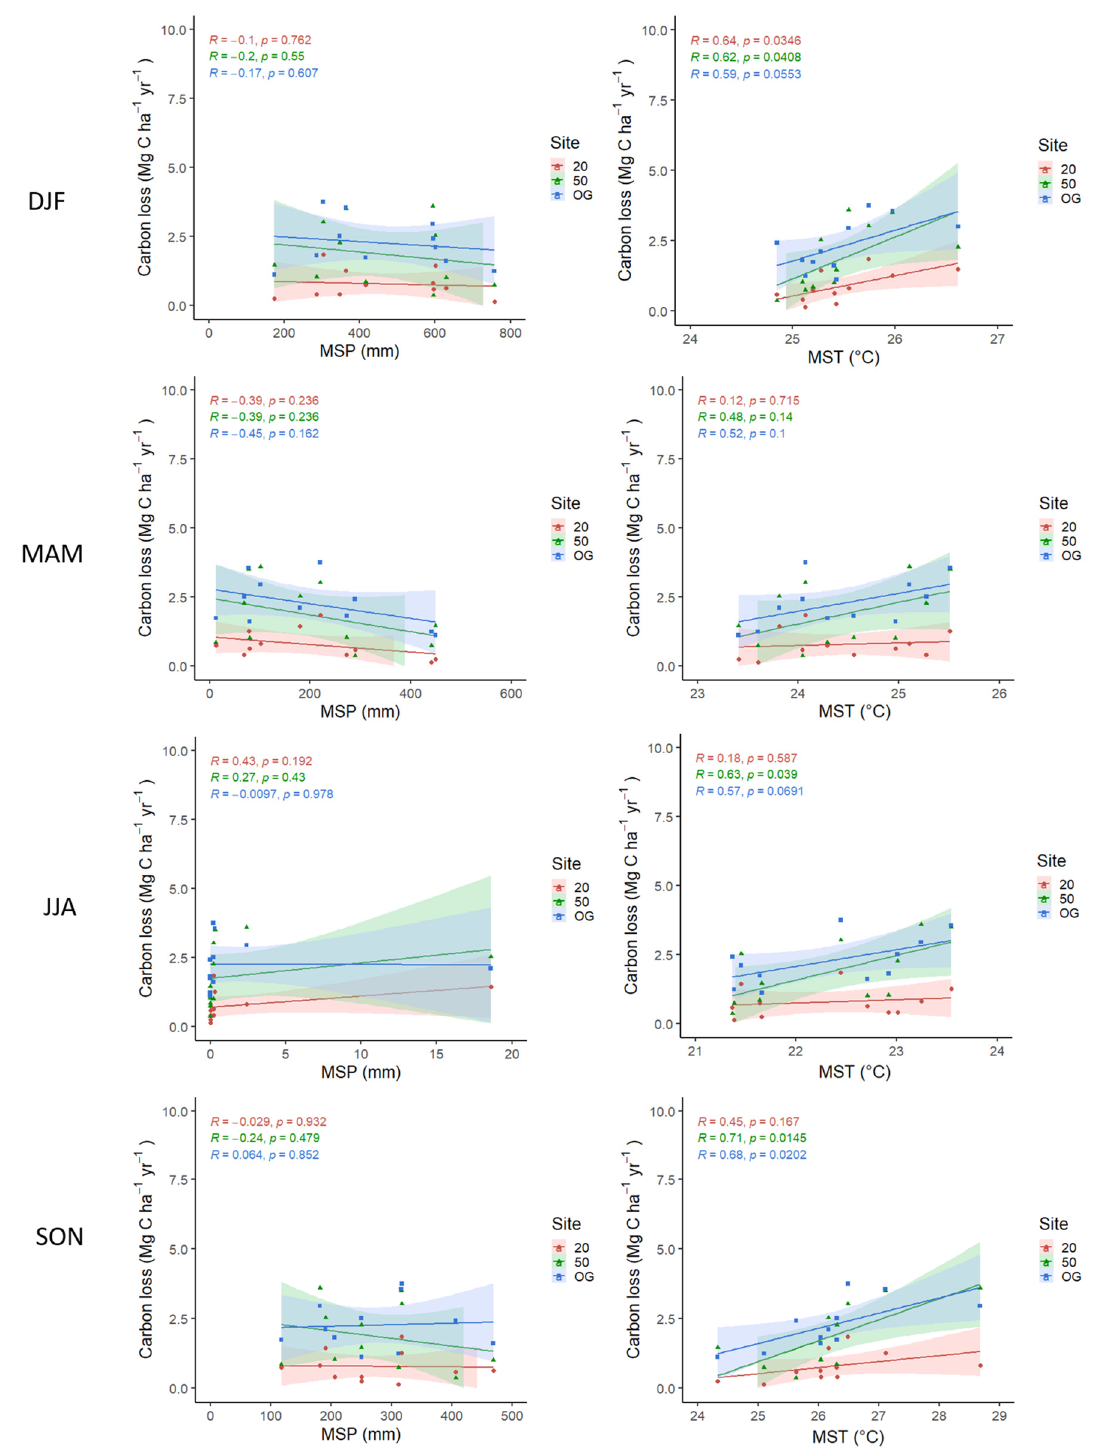
Figure 4. Pearson’s correlation coefficients for annual percentage of mortality (M%), annual percentage of recruitment (R%), annual carbon losses caused by mortality (C-loss), mean seasonal precipitation (MSP), mean seasonal temperature (MST), seasonal rainy days (RD), seasonal potential evapotranspiration (PET) and Oceanic El Nino Index (ONI) in Mata Seca State Park MSSP, and Santa Rosa National Park (SRNP). Only significant correlations ( p < 0.05) are shown in red or blue circles in the graph. DJF (December to February), MAM (March to May), JJA (June to August), SON (September to November), and DJF (December to February).